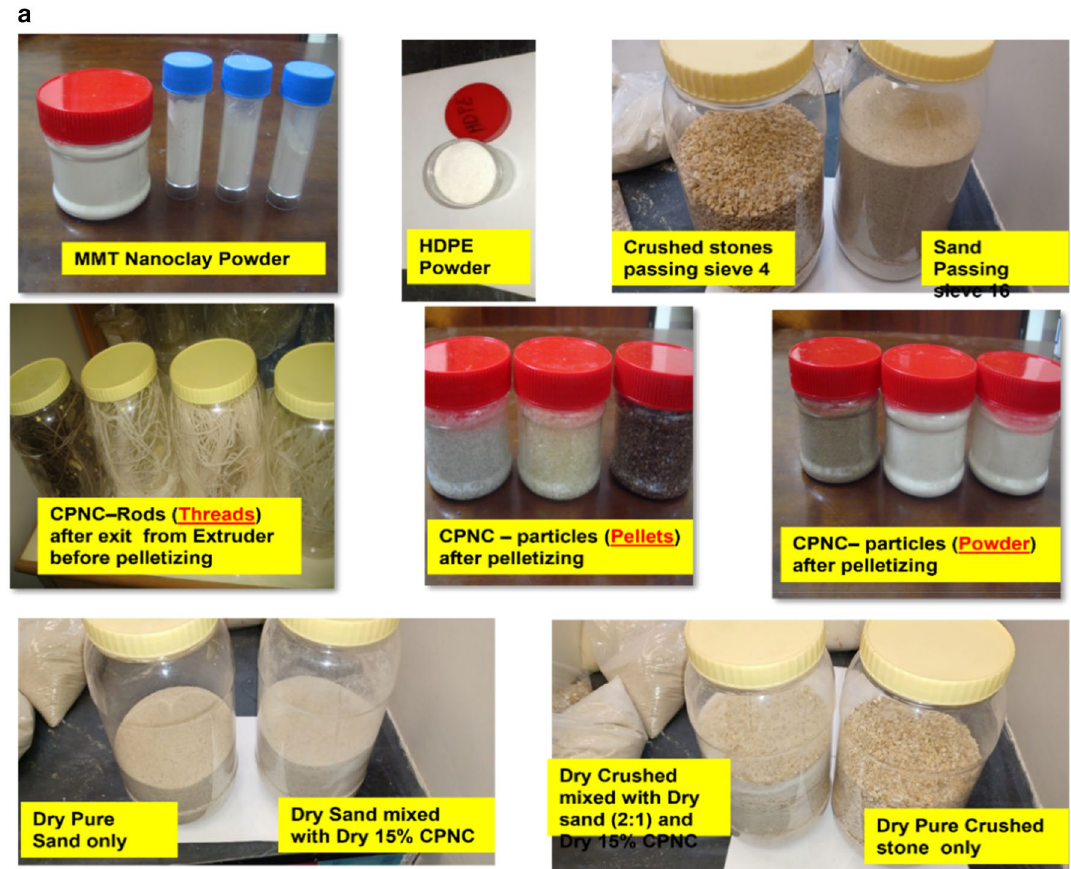
Figure 1. (a) Raw materials of MMT, HDPE, CPNC, CPNC-mortar and CPNC-concrete. CPNC is made of MMT and HDPE as hot rods; after cooling in a water bath, CPNC is converted into pellets and powder by a pelletizer before mixing with sand and crushed stones to produce CPNC concrete and CPNC-mortar. ( b) Sieve analysis of raw materials of MMT nanoclay, HDPE, and CPNC by using a laser particle analyser indicating the particle size and percentage ratio in the quantity of each material; examples are shown at ratios of 10%, 50%, and 90%, where the HDPE particle size is larger than the agglomerated MMT particle size before melting in the extruder. After mixing under high temperature and high shear effect, MMT is exfoliated and dispersed in HDPE chains producing CPNC rods. Then, the produced powder of CPNC has a particle size less than that of the original HDPE and agglomerated MMT particles. ( c) Extruding system for synthesizing CPNC from MMT and HDPE; the figure shows the controller lab station components, twin screw of 5 heating zones, die, feeders, cooling water bath and high-speed pelletizer, including the collector tank of the final CPNC powder. ( d) Electric oven for thermal casting of CPNC concrete and CPNC mortar. Electric oven and moulds of cylinders covered with aluminium foil during thermal casting; some CPNC-concrete cylinders are coated with thin aluminium sheets after thermal casting. Electric oven and moulds of CPNC mortar cubes covered with aluminium foil during thermal casting, CPNC mortar cubes coated with thin aluminium sheets after thermal casting, and CPNC mortar cubes after removing the aluminium sheets. Moulds of CPNC-concrete notched beams coated with thin aluminium sheets, and samples of CPNC concrete notched beams for fracture properties test. (e) Flowchart of CPNC, CPNC concrete and CPNC mortar, showing the manufacturing steps of CPNC through synthesis by the thermal extruding of melted 95% HDPE powder with 5% agglomerated MMT; there is extruding under high-shear twin screws of five different thermal zones, including the feeding zone and die at 250 °C, to exfoliate MMT into nanoplatelets and disperse them between melted HDPE chains, making bonds and finally exiting at the die zone. Then, the material is converted to powder in the pelletizer. Then, CPNC powder is mixed with sand or sand and crushed stones to produce CPNC concrete and CPNC–mortar under thermal casting in electrical or microwave ovens. ( f) Model of CPNC particles showing nanoclay sheet arrangement inside HDPE, CPNC-mortar and CPNC-concrete showing CPNC particle distribution around aggregate particles; the sizes are analysed by the wet